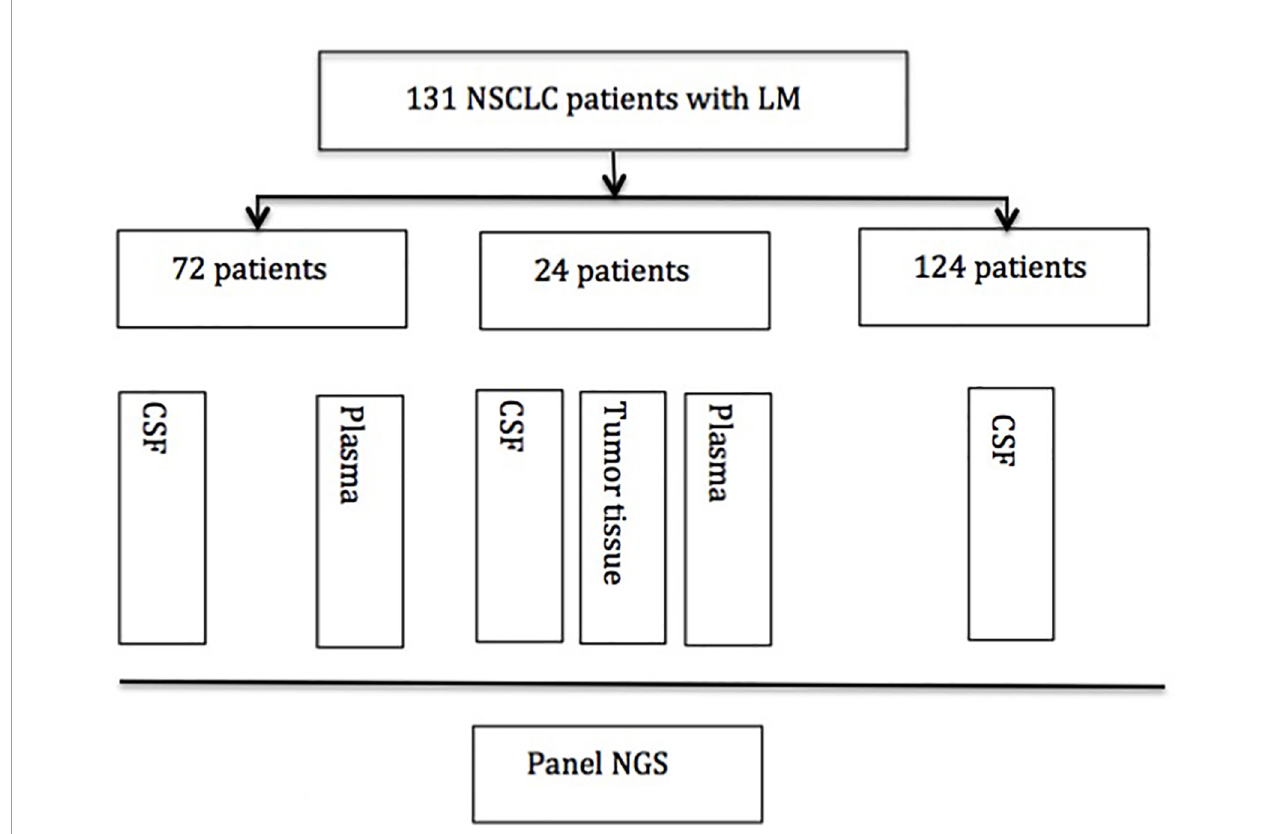
FIGURE 1 | Experimental pro fi le. NSCLC, nonsmall cell lung cancer; CSF, cerebrospinal fl uid; NGS, next-generation